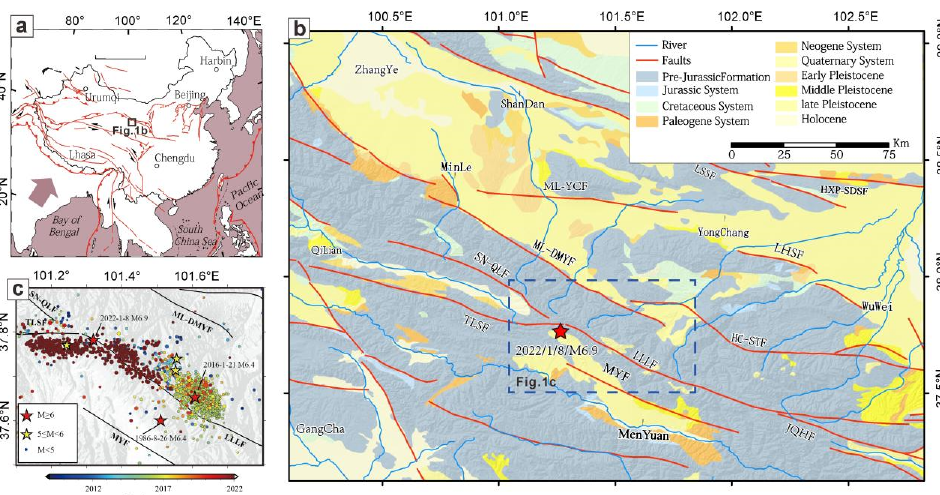
Figure 1. Regional tectonic map and historical earthquakes in the Menyuan region. The red star denotes the epicenter of the M s 6.9 Menyuan earthquake. LLLF: Lenglongling fault; TLSF: Tuolaishan fault; SN-QLF: Sunan-Qilian fault; MYF: Menyuan fault; ML-DMYF: Minle-Damaying fault. Informa- tion obtained from the earthquake catalog of the CENC. The 3 panels reflect the regional geological structure characteristics of this study from different spatial scales. Subfigure ( a ) shows the location of the Menyuan earthquake in China. Subfigure ( b ) shows the geological structure background of the Menyuan earthquake discussed in this paper. Subfigure ( c ) shows the spatial distribution of historical earthquakes in Menyuan from 2008 to